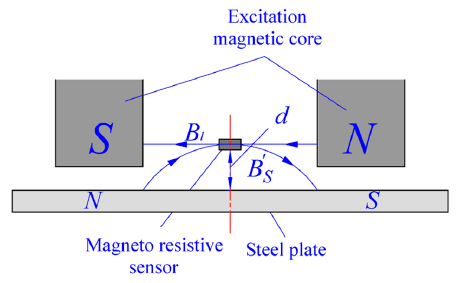
Figure 2. Schematic diagram of magnetic induction for sensor detection